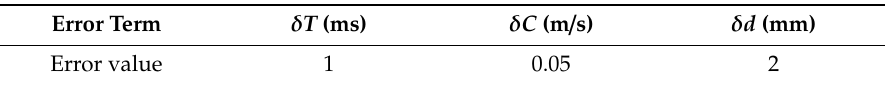
Table 1. Error parameters.